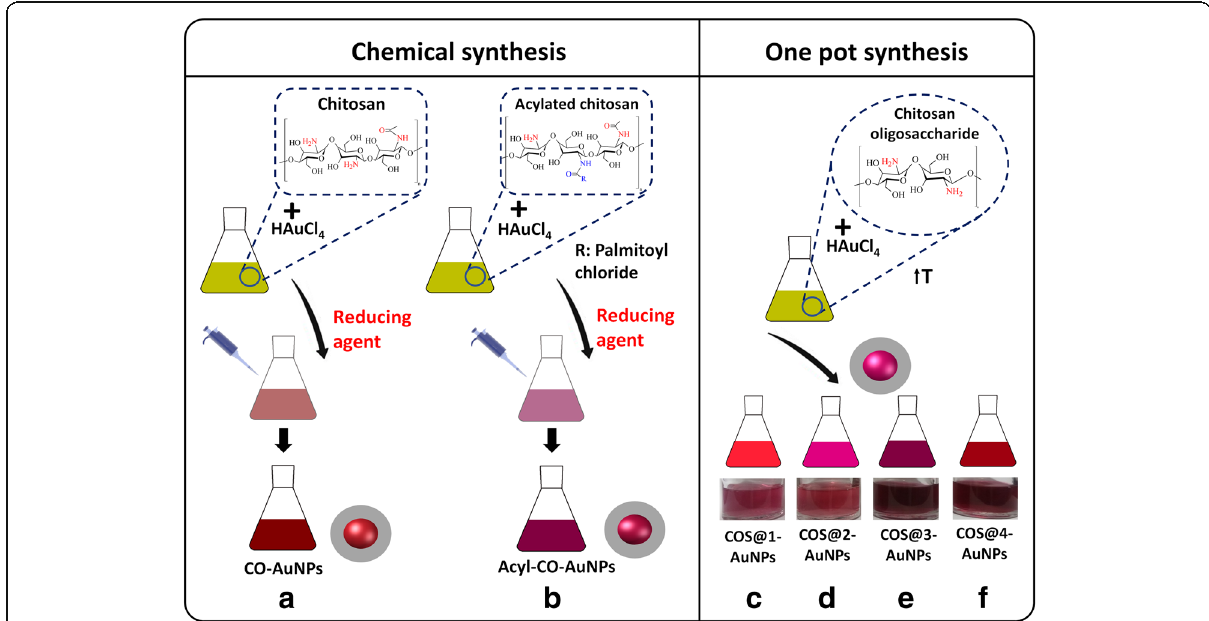
Fig. 2 Schematic diagram for each synthesis: a – b chemical synthesis for gold nanoparticles with chitosan in its simple form (CO-AuNPs) and with hydrophobically modified acyl groups (Acyl-CO-AuNPs) and c – f green/one-pot synthesis for short chain chitosan (chitosan oligosaccharide,